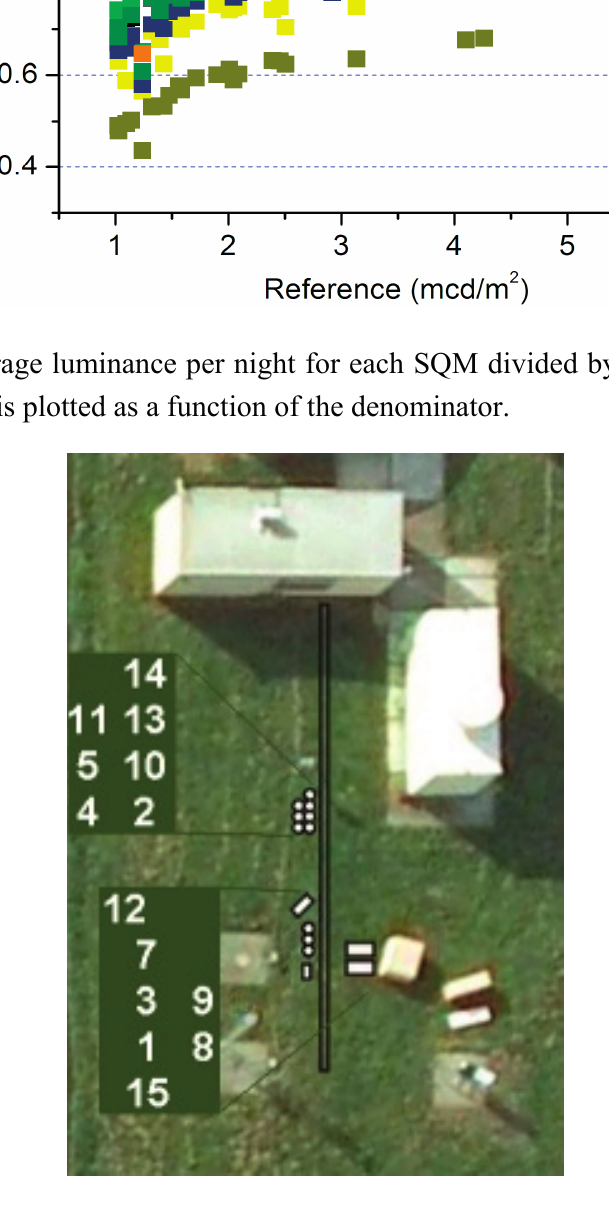
Figure 3. Top view of the CLIC instrument setup of the SQMs. Locations are indicated by white circles and rectangles. Insets show the corresponding numbers. As SQM 6 arrived late on the site and did not join the official CLIC-campaign period, it was placed at location 11 after the